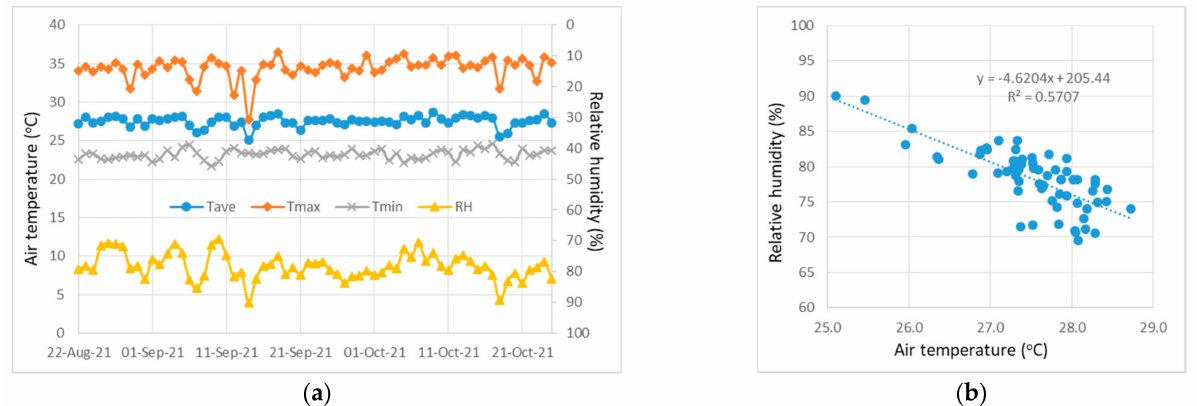
Figure 5. ( a ) Daily maximum, average, and minimum air temperatures, and relative humidity; ( b ) linear correlation between daily average air temperature and relative